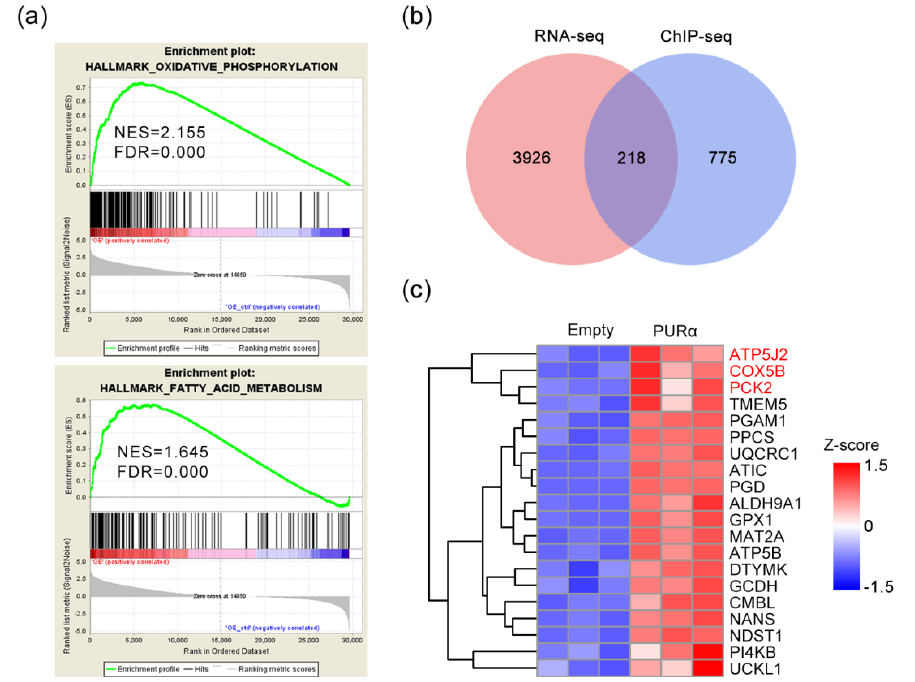
Figure 3. Analysis of RNA-seq and ChIP-seq. ( a ) GSEA of PURα-regulated genes with normalized enrichment score (NES) and false-discovery rate (FDR). ( b ) Venn diagram showing the overlap of DEGs between RNA-seq (logFC ≥ 0.5 or ≤ -0.5, p ≤ 0.01, FDR ≤ 1.5%) and ChIP-seq (logFC ≥ 1 or ≤ -1, p ≤ 0.01, FDR ≤ 1.5%). ( c ) Heat map depicting changes in gene expression levels involved in fatty acid